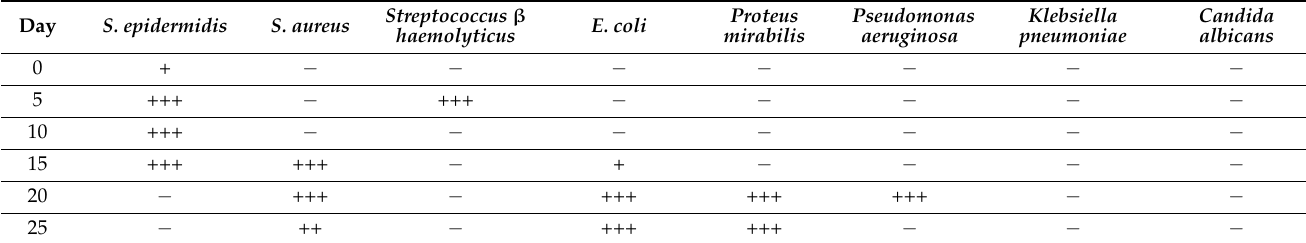
Table 6. Identification of pathogens grown from the wound treated with silver salt of sulfathiazole.